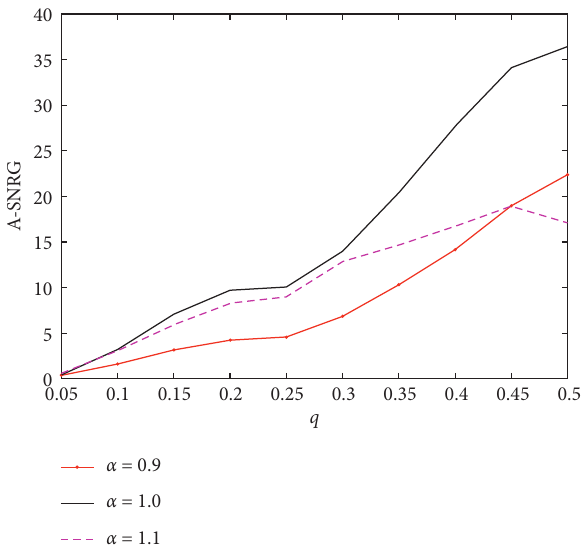
Figure 13: A-SNRG of SR with asymmetric depth and width of the potential well, as a function of the potential function parameter. (a) a and (b) b . 0